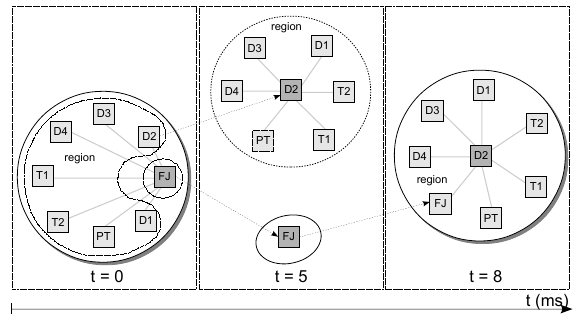
the original region.